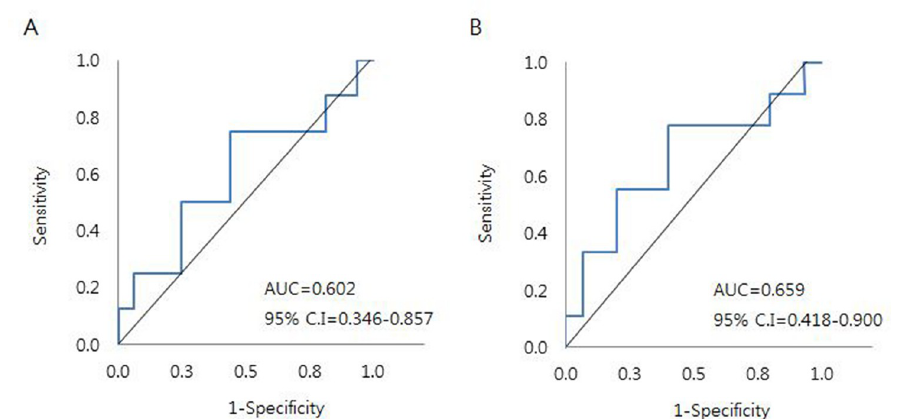
Fig 3. Receiver operating characteristics curve analysis of the effects of CT reticulation indexes on the epifascial and subfascial lymphatic system dysfunction. Maximal value of CT reticulation index can distinguish (A) lymphoscintigraphic stages III and IV from stages I and II and (B) stage IV from stages I, II, and III. AUC. area under the curve; CI, confidence interval.